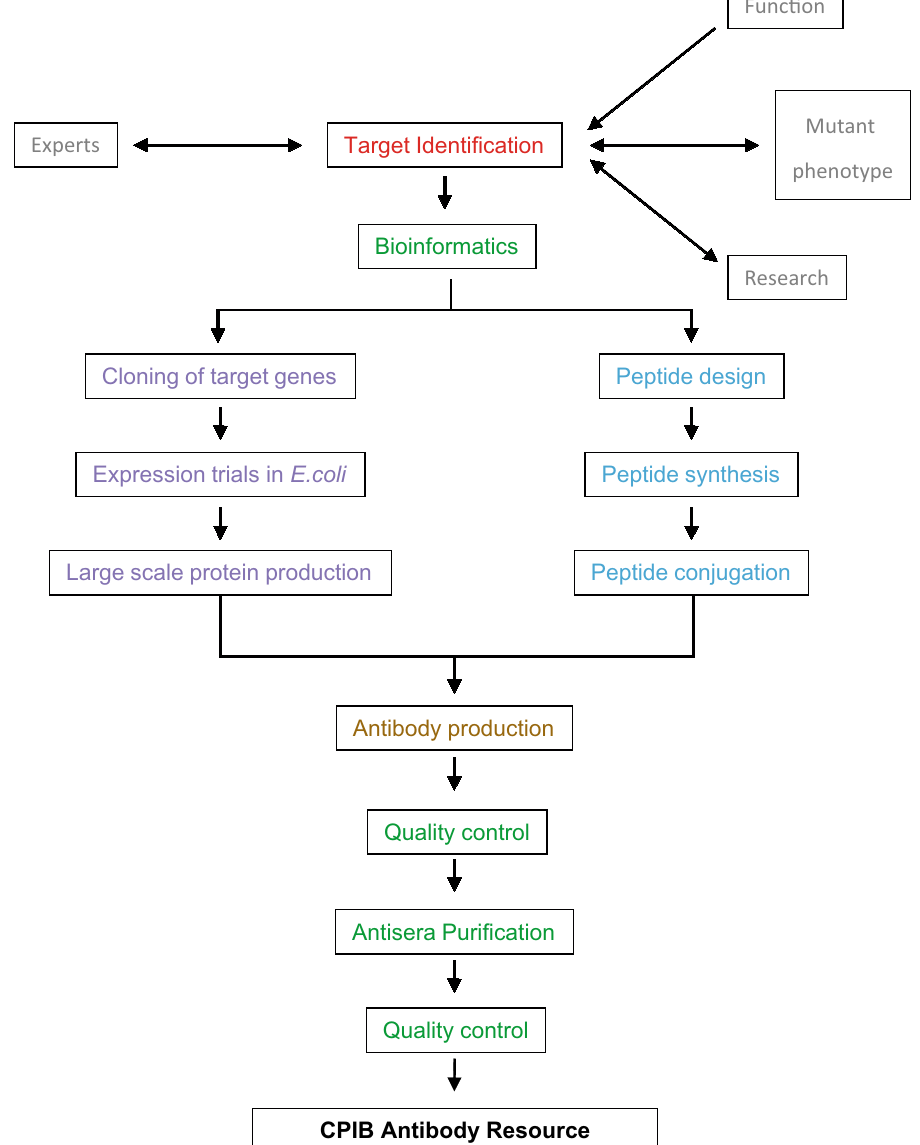
Figure 1. CPIB antibody pipeline. Targets for antibody production were identified and highly antigenic regions were determined by bioinformatics analysis. The proteins were then expressed in E. coli , purified by affinity chromatography and used for immunisation. Antibodies were then checked by dot blots, Westerns and in situ immuno-localisation and affinity purified if